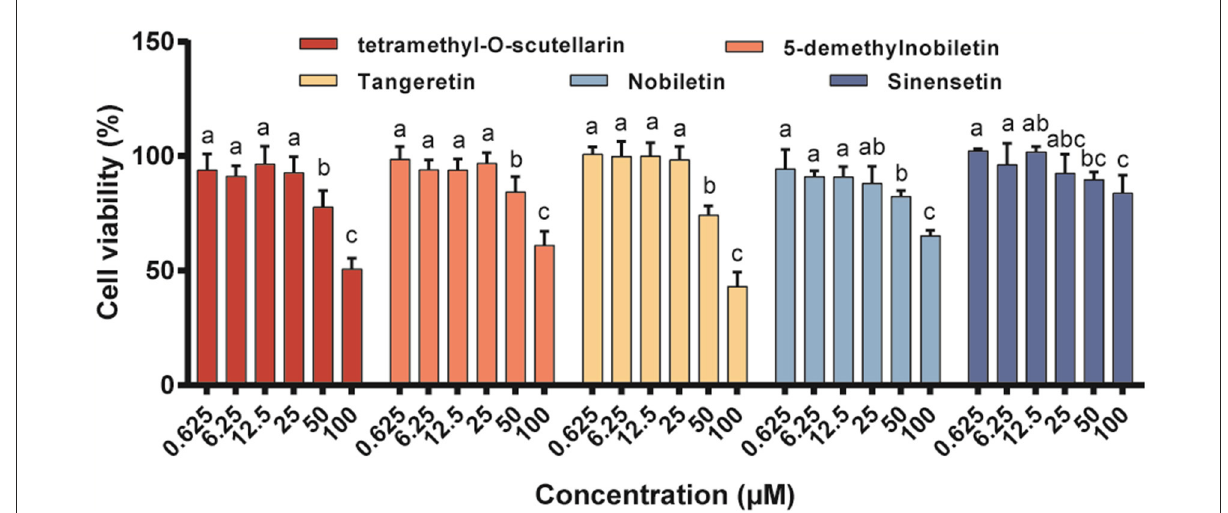
FIGURE2 Effects of different PMFs on cell viability of murine RAW 264.7 macrophages. Data were presented as the means ± SD for three independent experiments. Means denoted by different lower-case letters were significantly different (One-way ANOVA, Dunnett’s post-hoc test, p <